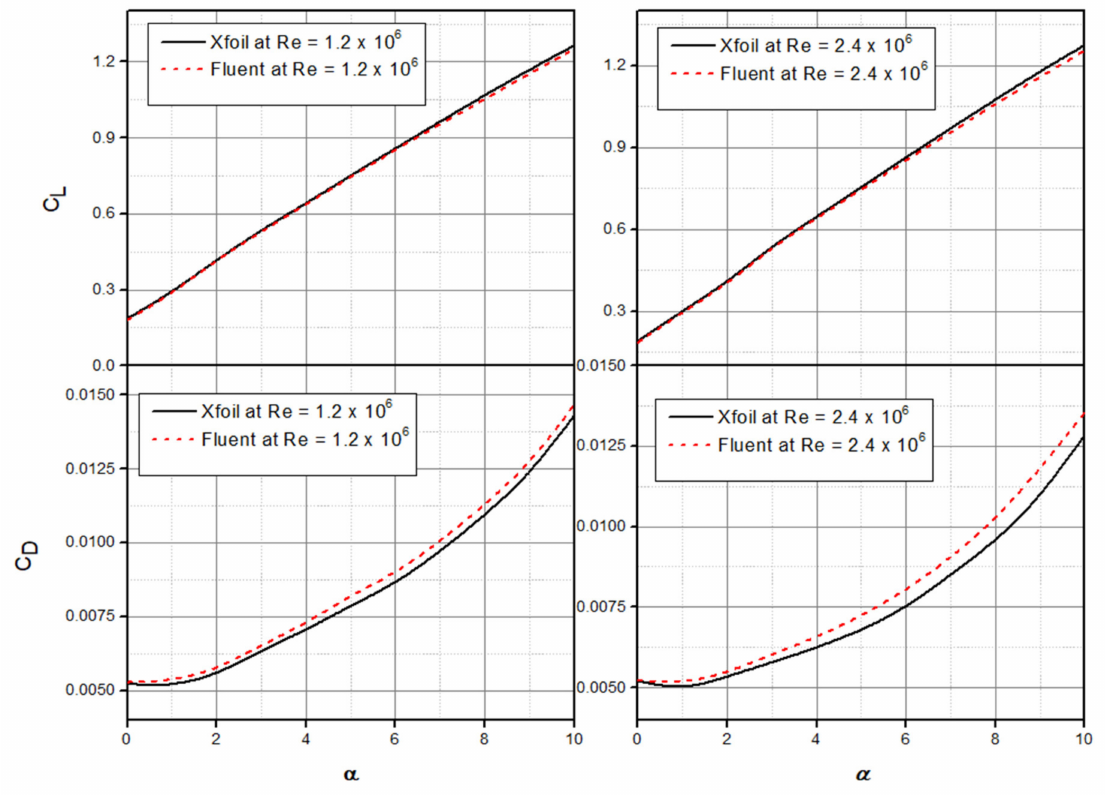
Figure 8. Aerodynamic lift and drag coefficient variations using the XFoil and Fluent